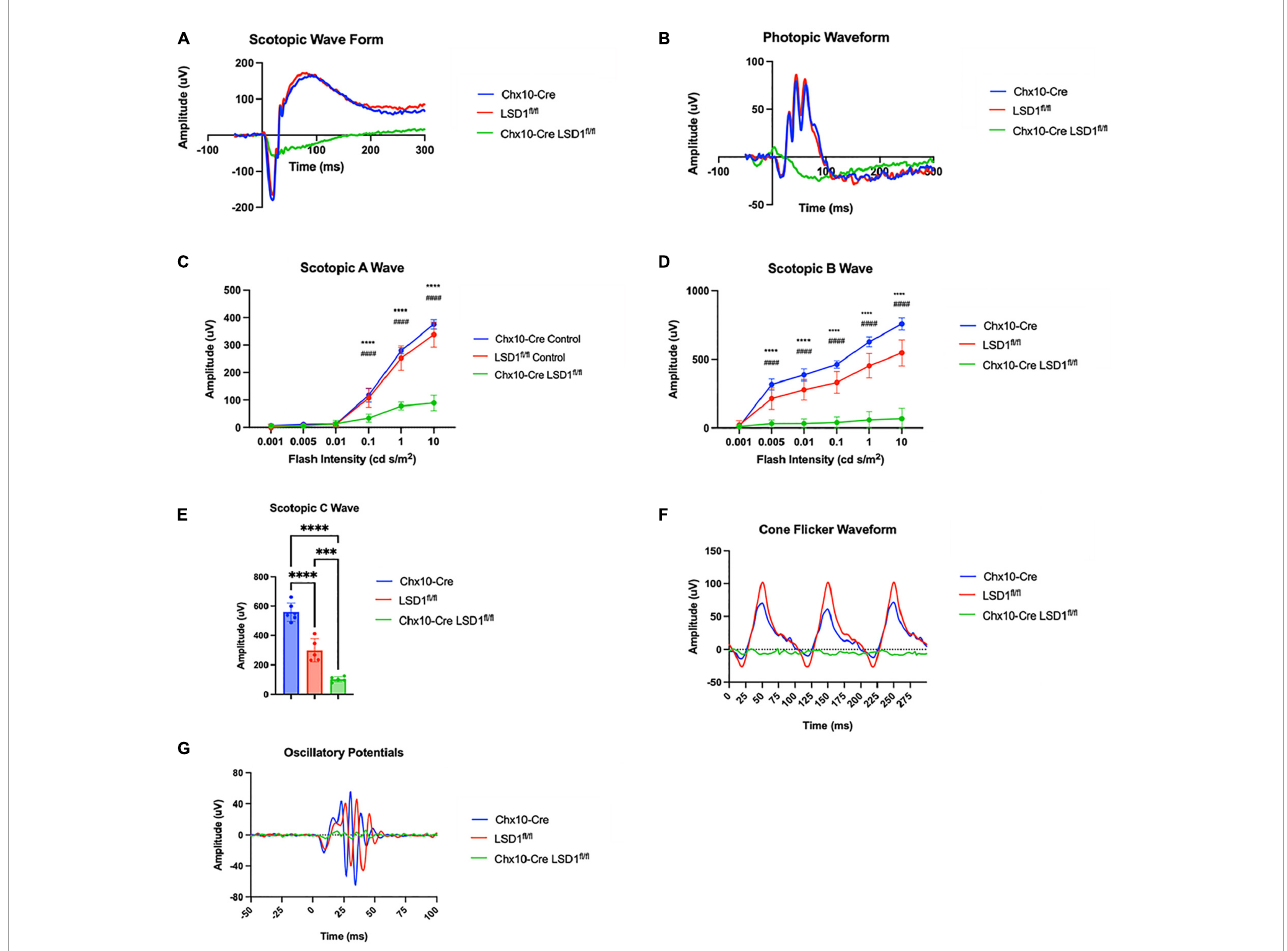
FIGURE2 Chx10-Cre Lsd1 fl / fl mice have relatively flat ERG response in scotopic and photopic conditions compared to controls. Raw electroretinogram waveforms from Chx10-Cre controls, Lsd1 fl / fl controls and Chx10-Cre Lsd1 fl / fl in scotopic (A) and photopic (B) conditions after a 10 cd s/m 2 light flash. At multiple flash intensities, both control groups show a relatively normal response for scotopic a-wave (C) , scotopic b-wave (D) , and scotopic c-wave (E) ; however, the Chx10-Cre Lsd1 fl / fl mice have significant reductions in ERG response, suggesting dysfunctional photoreceptors and bipolar cells. The Chx10-Cre Lsd1 fl / fl mice also have profound reductions in cone flicker response at 10 Hz compared to controls (F) as well as reductions in oscillatory potentials (G) . Two–Way ANOVA with Tukey’s multiple comparisons test *** , ### p -value < 0.001; **** , #### p -value < 0.0001. *Symbols indicate significance between Chx10-Cre controls and Chx10-Cre Lsd1 fl / fl ; # symbols indicate significance between Lsd1 fl / fl controls and Chx10-Cre Lsd1 fl / fl . Samples sizes: Chx10-Cre ( n = 6–7), Lsd1 fl / fl ( n = 5), Chx10-Cre Lsd1 fl / fl ( n = 4–5). Full list of statistical results can be found in Supplementary Tables 2 – 4